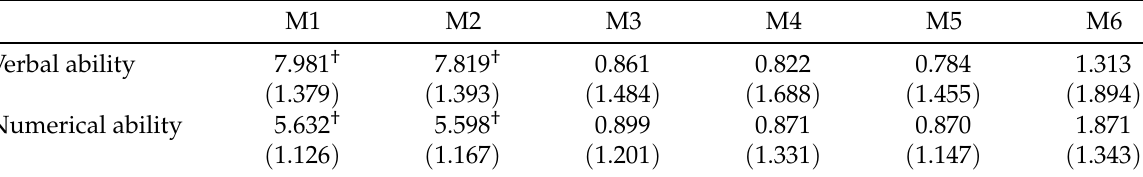
Table 1: NDE R of G1 education on G3 verbal ( n = 1, 898) and numerical ability ( n = 1,